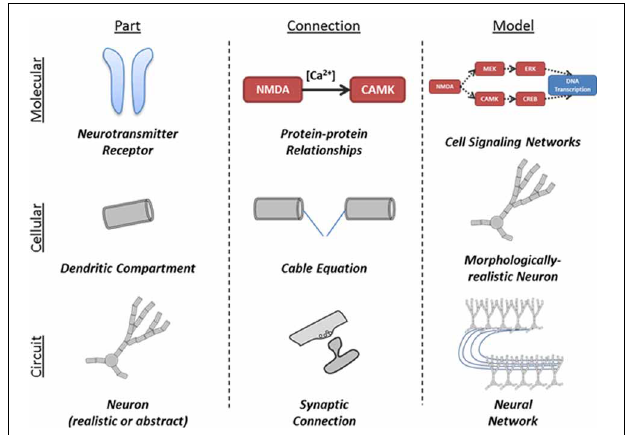
FIGURE 3 | Illustration of application of part-connection-model framework to different scales of neural simulations. The structure of the N2A language allows it to be applied in scales ranging from molecular kinetics models of cell signaling to neural network models comprised of complex neurons and